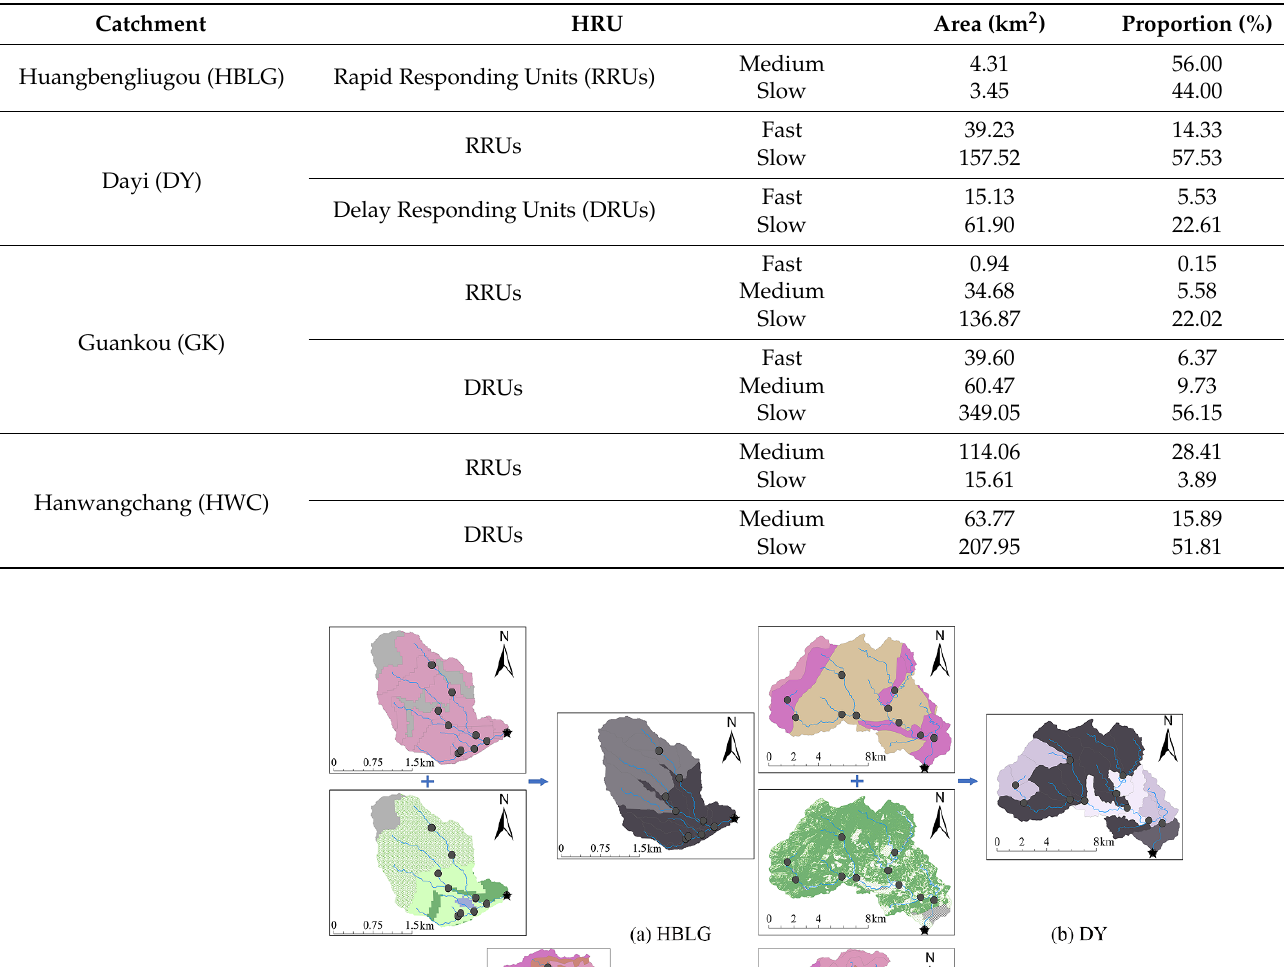
Table 4. Divisions of hydrological response units (HRUs).